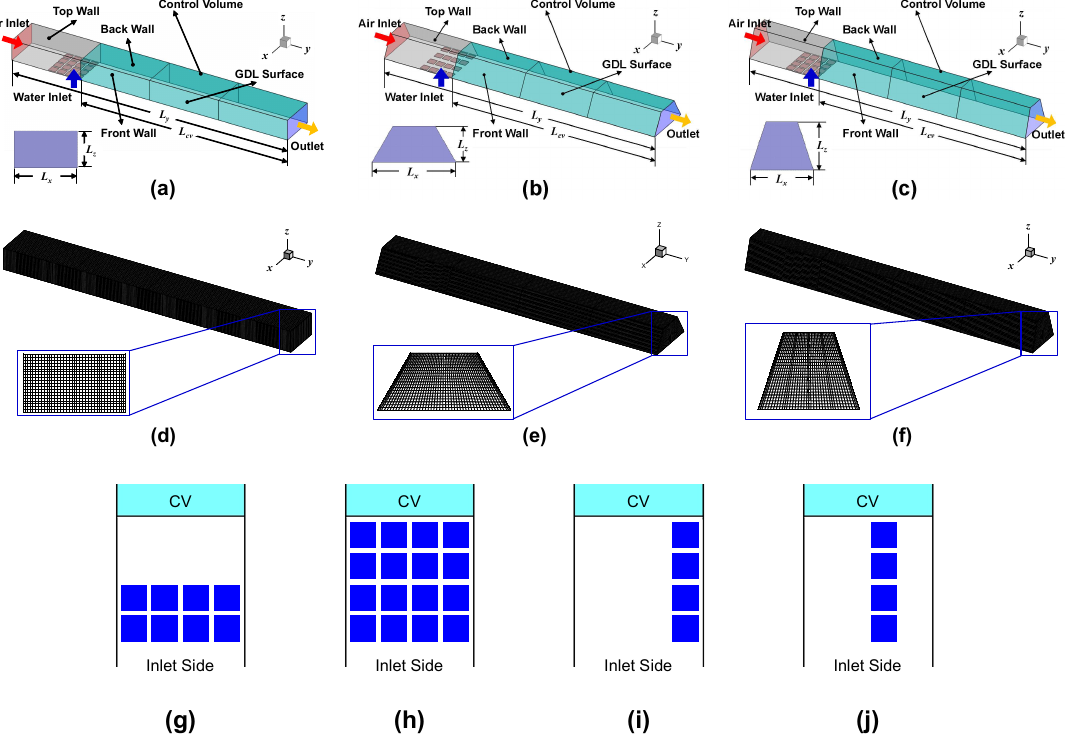
Figure 1. Three dimensional computational domains and grids considered in the present study: ( a ) rectangular channel cross section (REC); ( b ) trapezoidal channel cross sections with open angles of 60 ◦ (T60); ( c ) trapezoidal channel cross sections with open angles of 72 ◦ (T72), ( d ) computational grid (REC); ( e ) T60; ( f ) T72; ( g ) water inlet configuration (H12); ( h ) H1234; ( i ) V1; and ( j )